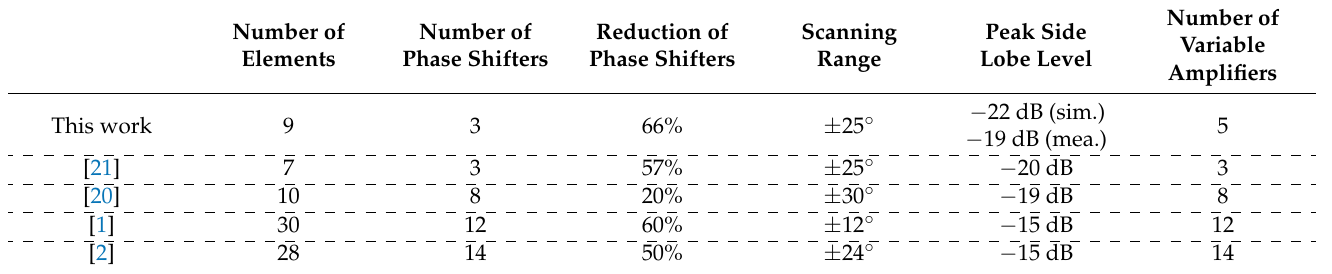
Table 3. A comparative analysis of the proposed feeding system with respect to other design cases based on linear array